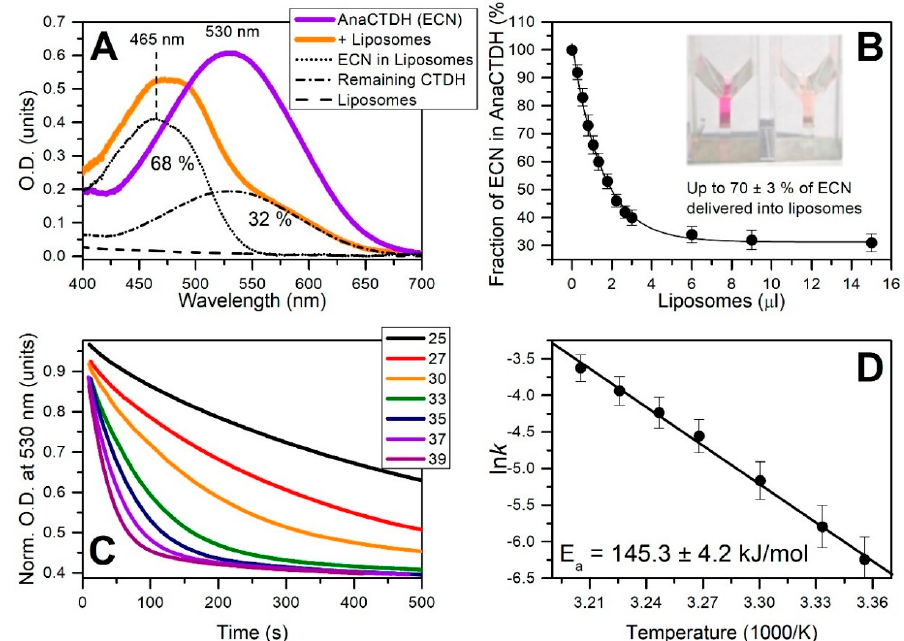
Figure 3. ECN delivery by AnaCTDH(ECN) holoprotein into liposomes. ( A ) The absorption spectrum of AnaCTDH(ECN) before (purple) and after addition of liposomes (orange). The percentage of carotenoid remaining in AnaCTDH after addition of liposomes was determined by decomposing the resulting spectrum into AnaCTDH(ECN) absorption and scattering of liposomes, considering also the fact that ECN absorption in liposomes, peaked at ~ 465 nm, is significantly blue-shifted and does not overlap with protein-bound ECN in the 550–700 nm region. ( B ) The percentage of carotenoid remaining in AnaCTDH upon increasing the concentration of liposomes in solution. Values are presented as mean ± SD from three independent experiments. The dependency was approximated by an exponential function in order to determine the maximum yield of carotenoid delivery. The inset shows cuvettes with the AnaCTDH(ECN) holoprotein solution before (left) and after (right) incubation with liposomes. ( C ) Time-courses of optical density at 530 nm corresponding to the disappearance of the AnaCTDH(ECN) holoprotein due to carotenoid delivery into liposomes at different temperatures (shown in °C). ( D ) The corresponding temperature dependence of rate constants (Arrhenius plot). All values are presented as mean ± SD from three independent experiments.